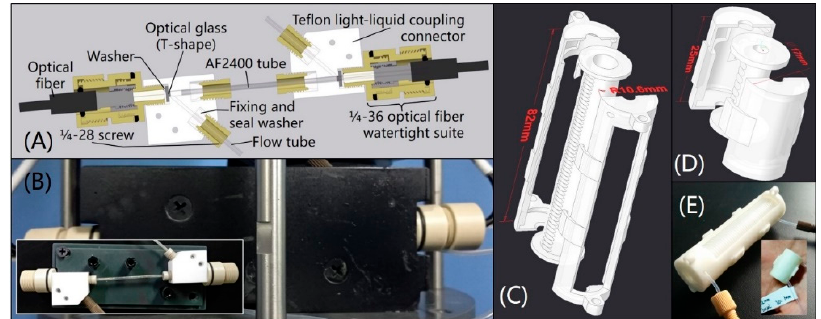
Figure 2. ( A ) Cross-section of the liquid waveguide capillary cell (LWCC) module; ( B ) photo of the LWCC module; ( C ) three-dimensional model of tube looper for internal diameter (E.D.) = 0.8 mm, external diameter (E.D.) = 1.6 mm, length = 1989 mm Teflon tube, total tube volume is 1 mL; ( D ) three- dimensional model of tube looper for I.D. = 1 mm, E.D. = 2 mm, length = 382 mm Teflon tube, total tube volume is 0.3 mL; ( E ) photos of above 1 mL and 0.3 mL tube loopers.